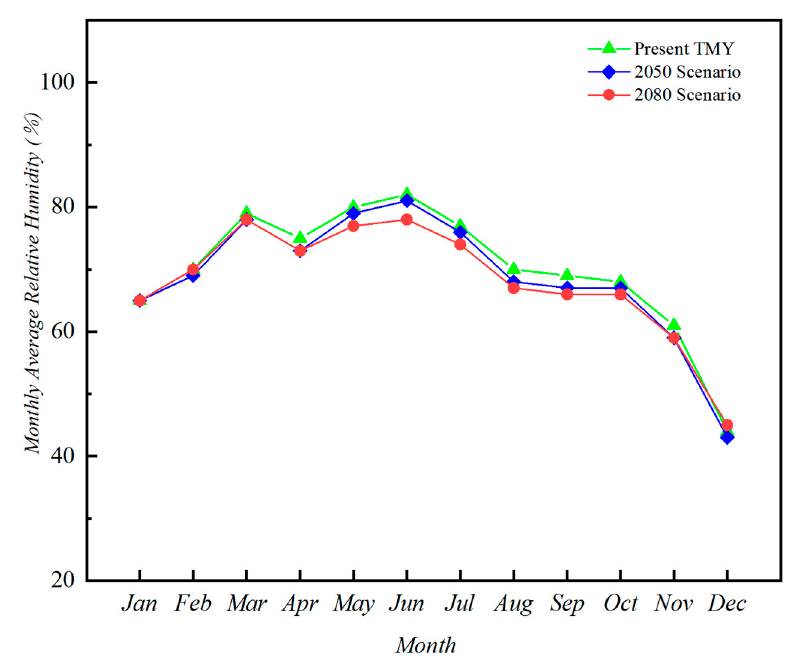
Figure 10. Monthly average relative humidities of present TMY and predicted future scenarios (2050 and 2080).